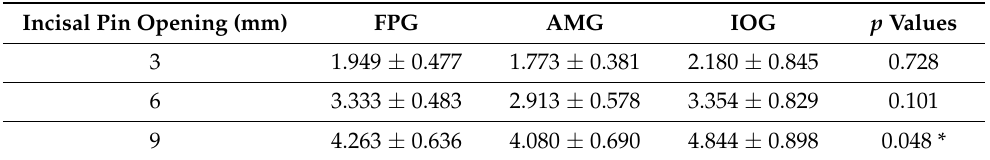
Table 1. Mean posterior openings in mm (Mean ± SD) of facebow preservation group (FPG), average mounting group (AMG), and intraoral group (IOG).